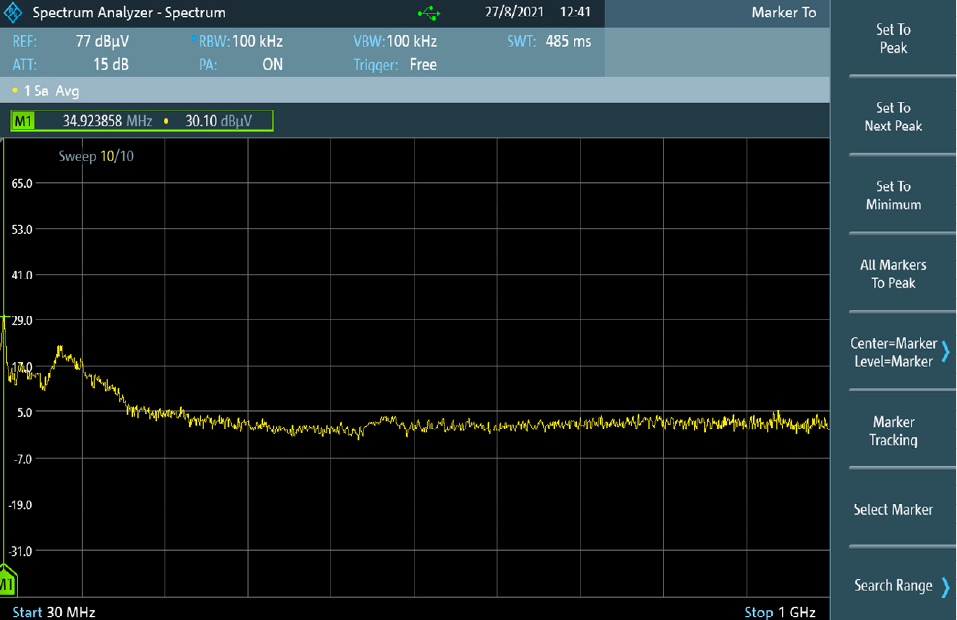
Figure 15. EMI measurement spectrogram of Block C1.